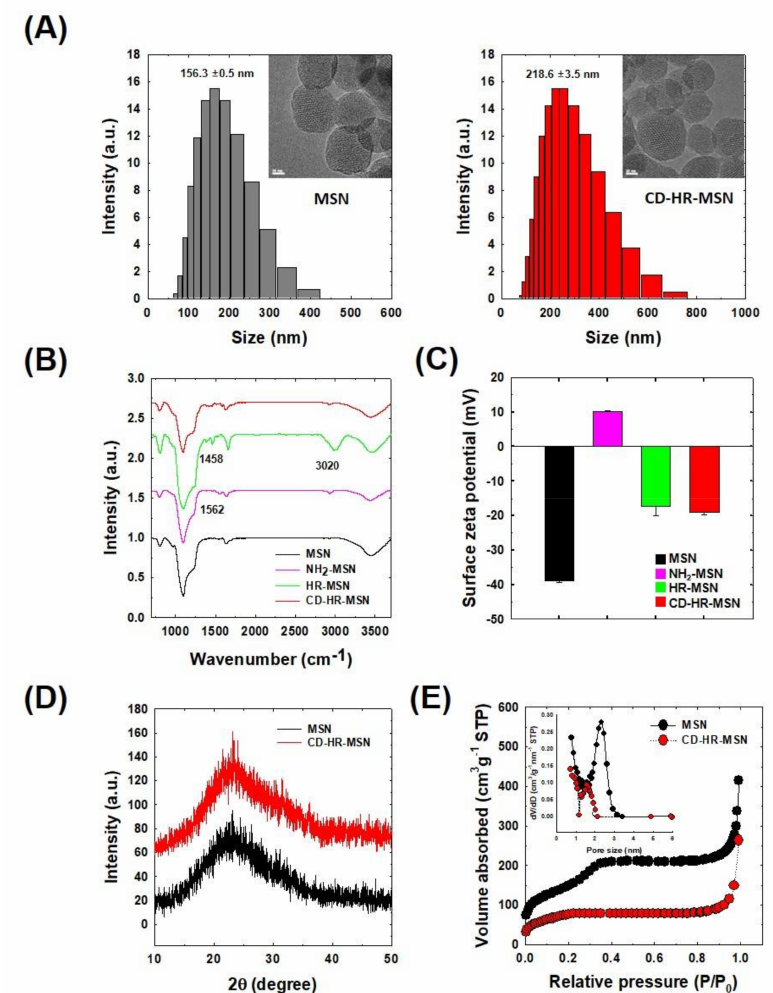
Figure 3. Physicochemical characteristics of functionalized MSNs. ( A ) TEM images and size distributions; ( B ) FT-IR spectra; ( C ) Change of surface zeta potential; ( D ) X-ray diffraction (XRD) spectra; and, ( E ) N 2 adsorption/desorption